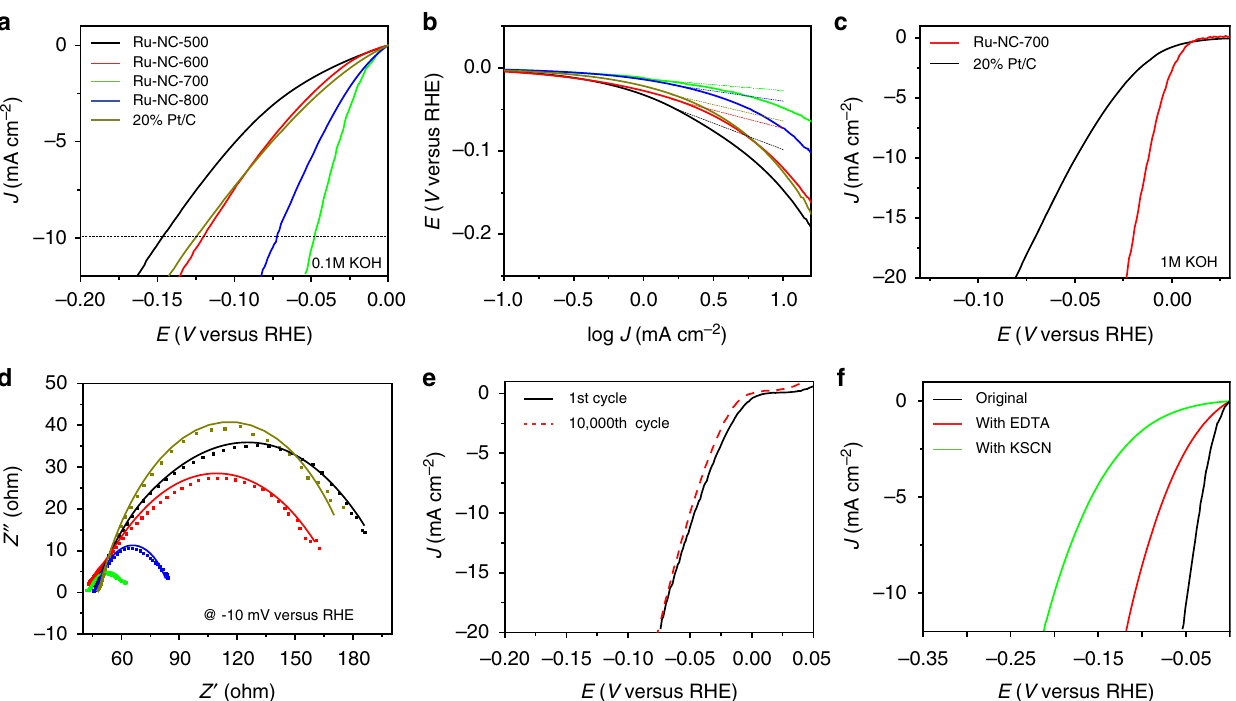
Fig. 4 Electrochemical measurements. a Linear sweep voltammetric (LSV) curves of Ru-NC- T and commercial 20 wt% Pt/C in 0.1 M KOH. b Tafel plots of Ru-NC- T and 20% Pt/C. The legends are the same as those in a . c LSV curves of Ru-NC-700 and 20% Pt/C in 1 M KOH. d Nyquist plots of Ru-NC- T and 20% Pt/C in 0.1 M KOH at − 10 mV vs. RHE. The legends are the same as those in a . Symbols are experimental data and solid curves are fi ts by Randles ’ equivalent circuit. e Stability test of Ru-NC-700 in 0.1 M KOH, before and after 10,000 cycles within the potential window of − 0.05 V to + 0.05 V vs RHE. f Catalyst poisoning experiment for Ru-NC-700 in 0.1 M KOH with the addition of 10 mM of ethylenediaminetetraacetic acid (EDTA, red curve) or 10 mM of potassium thiocyanate (KSCN, green